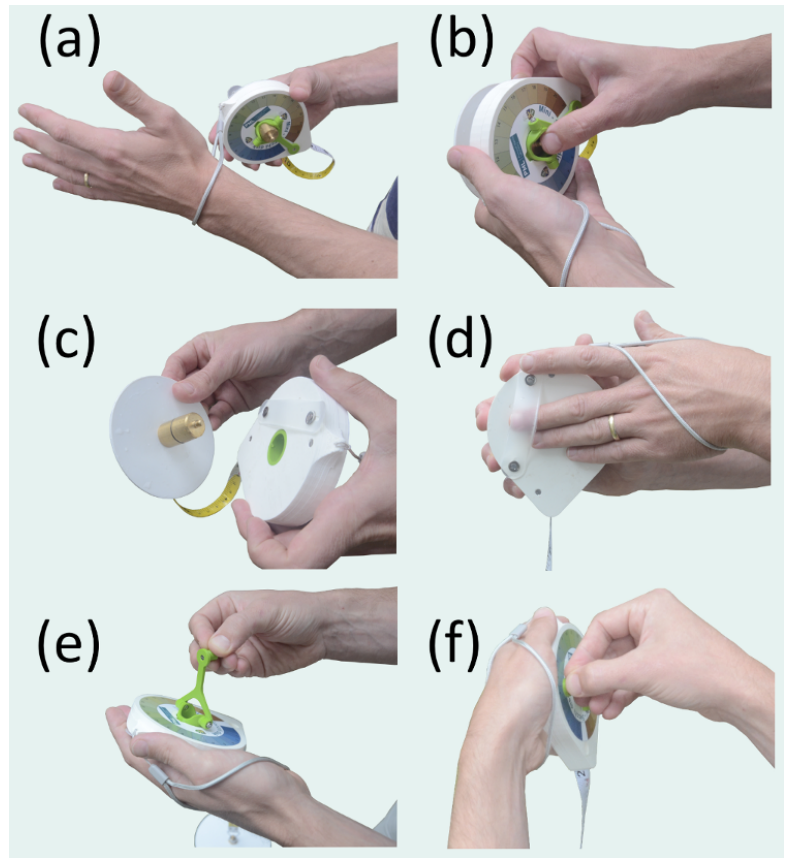
Figure 4. Operating the mini-Secchi disk. ( a ) Lanyard is slipped over the wrist and ( b ) weight pushed out from the bobbin. ( c ) Disk detached and ( d ) holding hand fingers slipped under the finger strap. ( e ) Handle is detached from the casing and flipped 180 degrees. ( f ) Handle is used to wind the tape measure in and out of the main body of the mini-Secchi